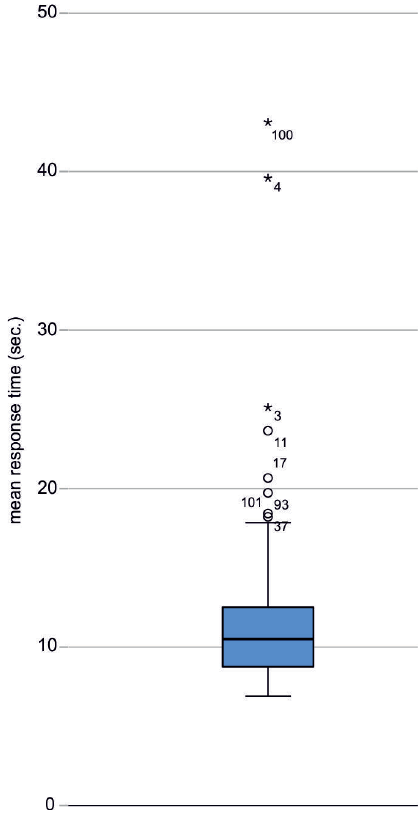
Fig. 3. Average response time of respondents. The remotest outliers (marked with an asterisk) were